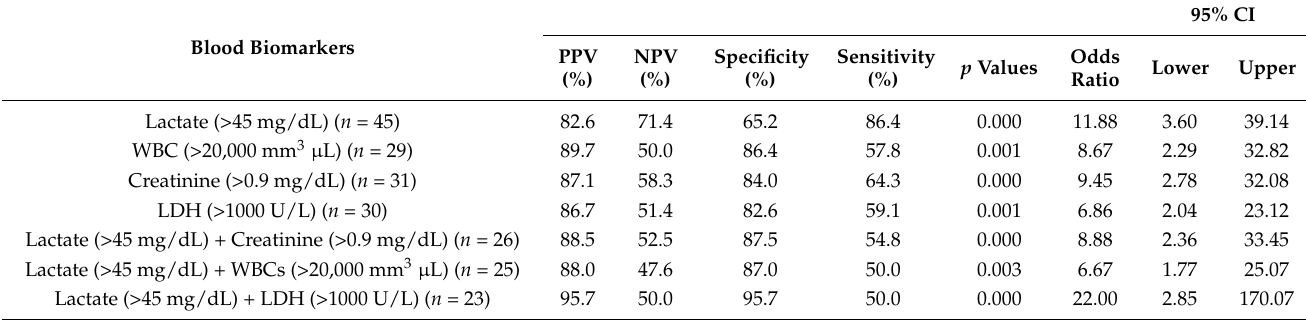
Table 5. Application of single and combined biomarkers to determine the odds ratio, PPV, NPV, sensitivity, and speci- ficity.